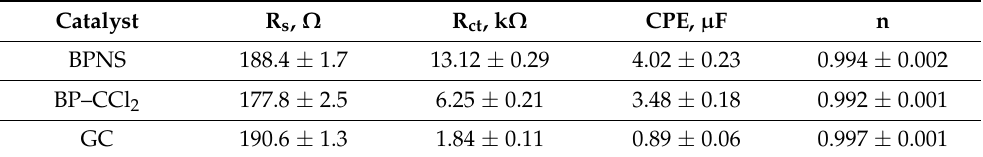
Table 1. The EIS parameters (R s , R ct , CPE, and the value of the exponent of the CPE (n)) obtained by fitting Nyquist diagrams using the equivalent circuit.